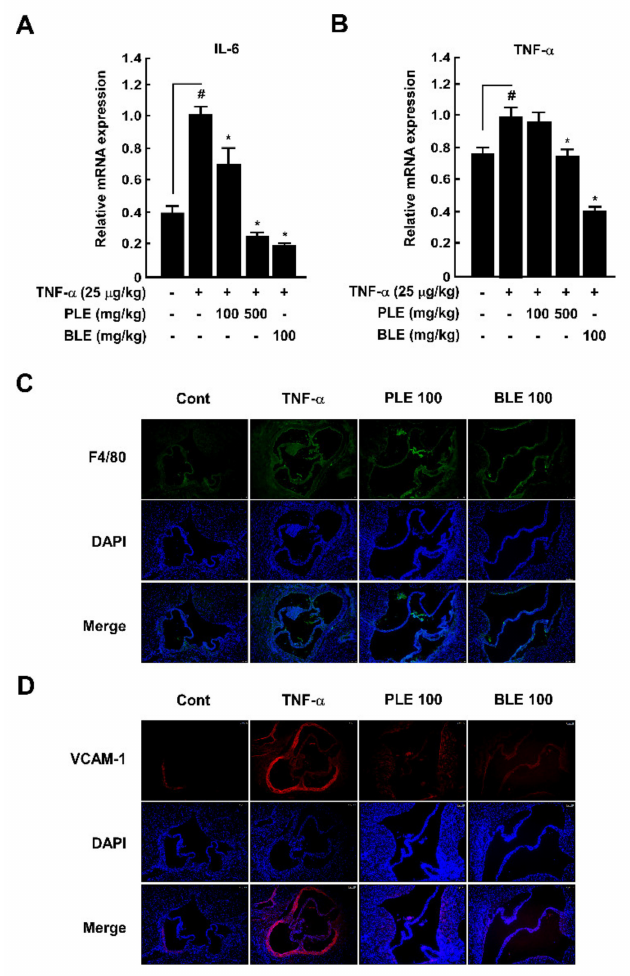
Figure 6. Paeonia lactiflora extract (PLE) rescued TNF- α -induced macrophage infiltration into the aortic root and suppressed IL6 and TNFA mRNA expression in the aorta. The relative mRNA levels of IL6 ( A ) and TNFA ( B ) were measured using qRT-PCR. Macrophage infiltration into the C57BL/6 mouse aortic root ( C ) and VCAM-1 expression ( D ) in the aorta of C57BL/6 mice following PLE and TNF- α treatment. # p < 0.05, compared with the control group; * p < 0.05, compared with the group exposed to TNF- α alone. Data are presented as the mean ± standard deviation of three independent